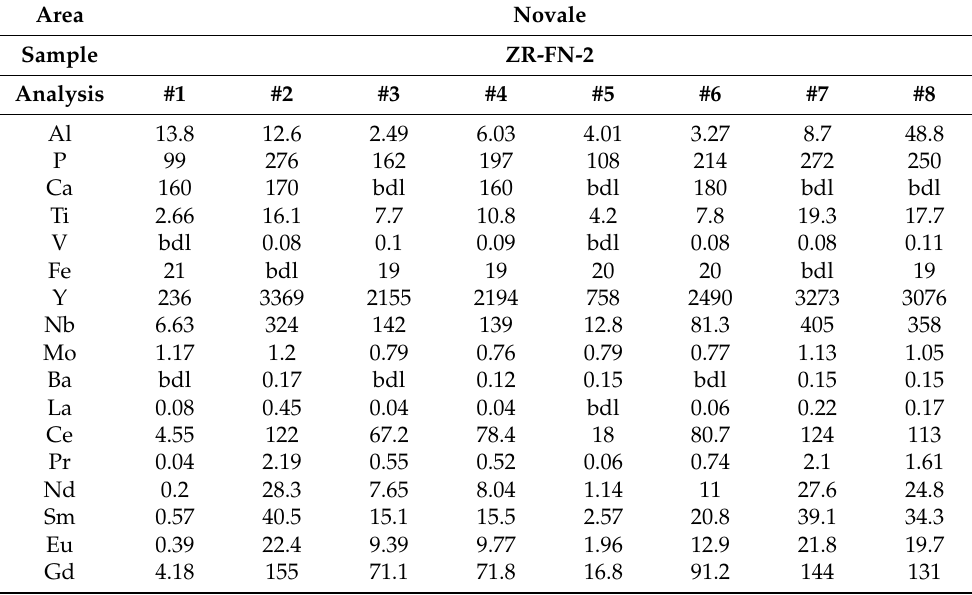
Table 5. LA- ICP-MS zircon analyses ( µ g/g) from Le Fosse di